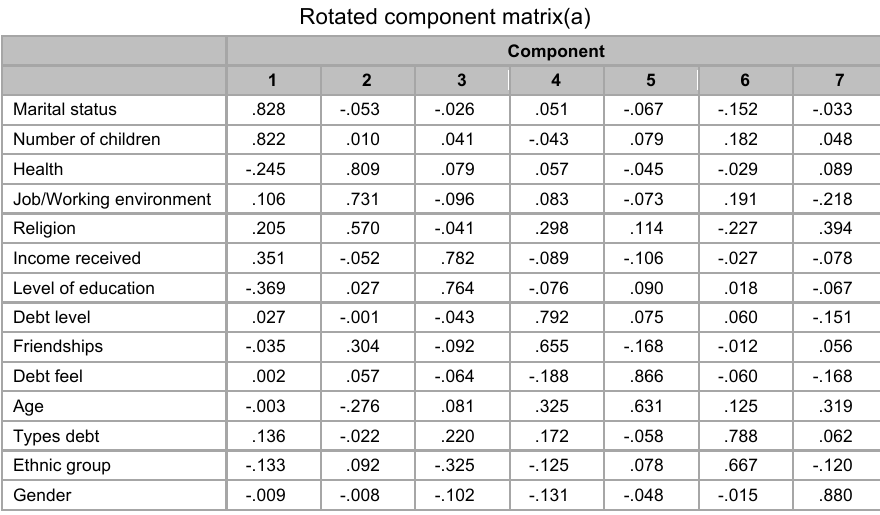
Rotated component matrix(a)